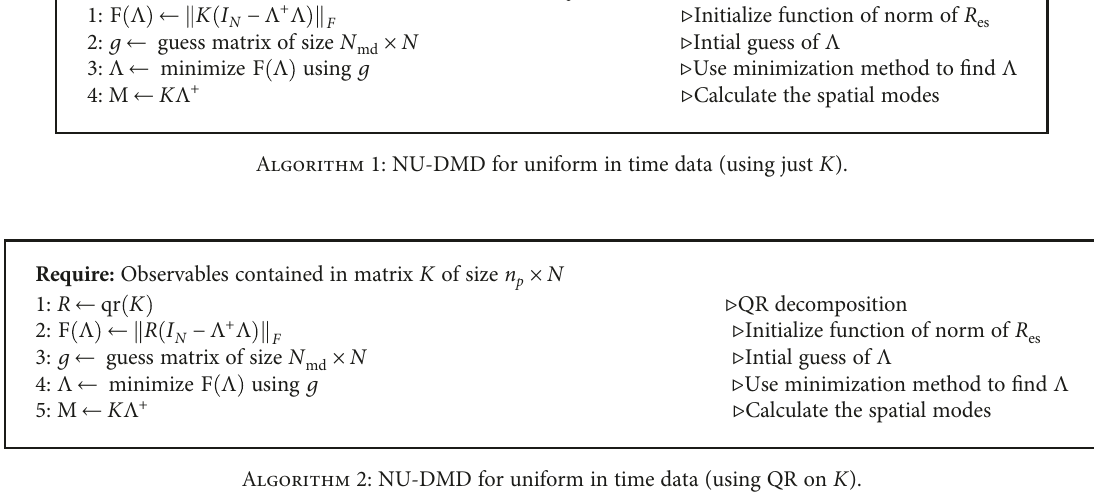
Algorithm 3 selects a subset of spatial points before con-